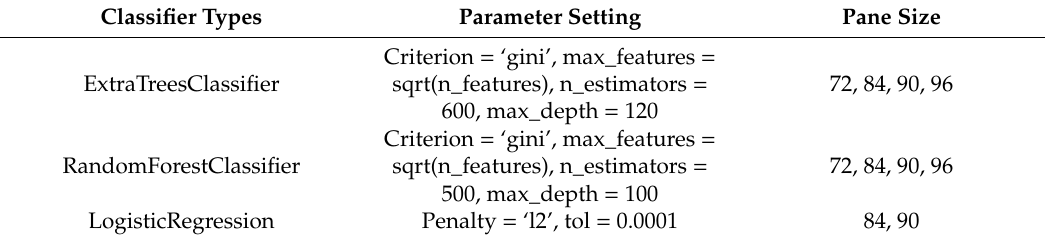
Table 10. Final configuration of multi-grained scanning.